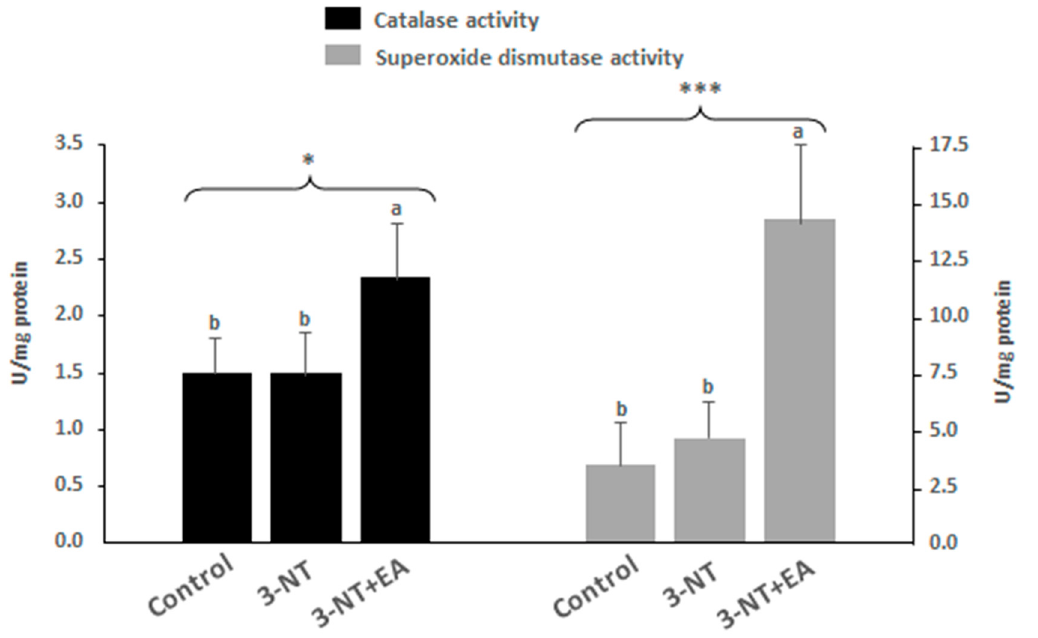
Figure 3. Antioxidant activity of catalase (black bars) and superoxide dismutase (grey bars) on differentiated human enterocytes upon exposure to 200 µ M 3-NT and 200 µ M 3-NT+200 µ M EA for 72 h. Asterisks on top of bars denote significant differences between group of samples in ANOVA (* p <0.05; *** p < 0.001).(a–b) Different letters on top of bars denote significant differences between means in post-hoc Tukey tests ( p <